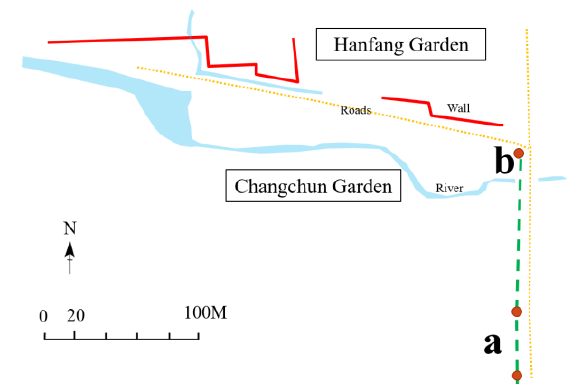
Figure 1. Diagrammatic representation of the north-eastern boundary identification.